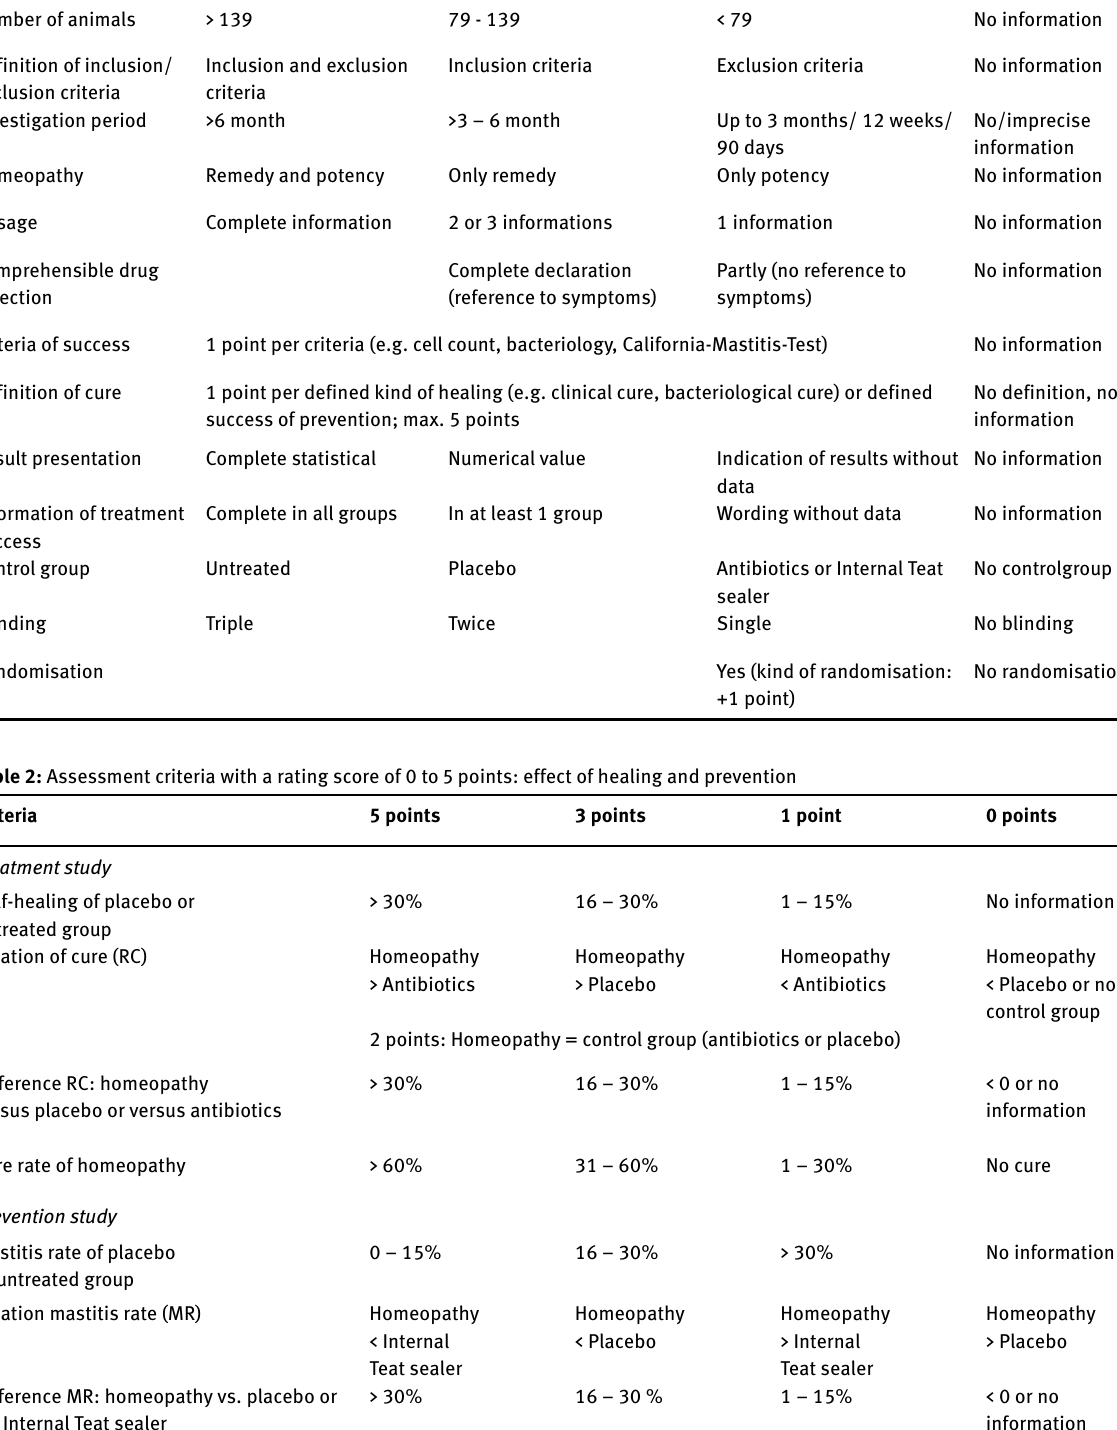
Table 1 : Assessment criteria with a rating score of 0 to 5 points: general information of the studies Criteria